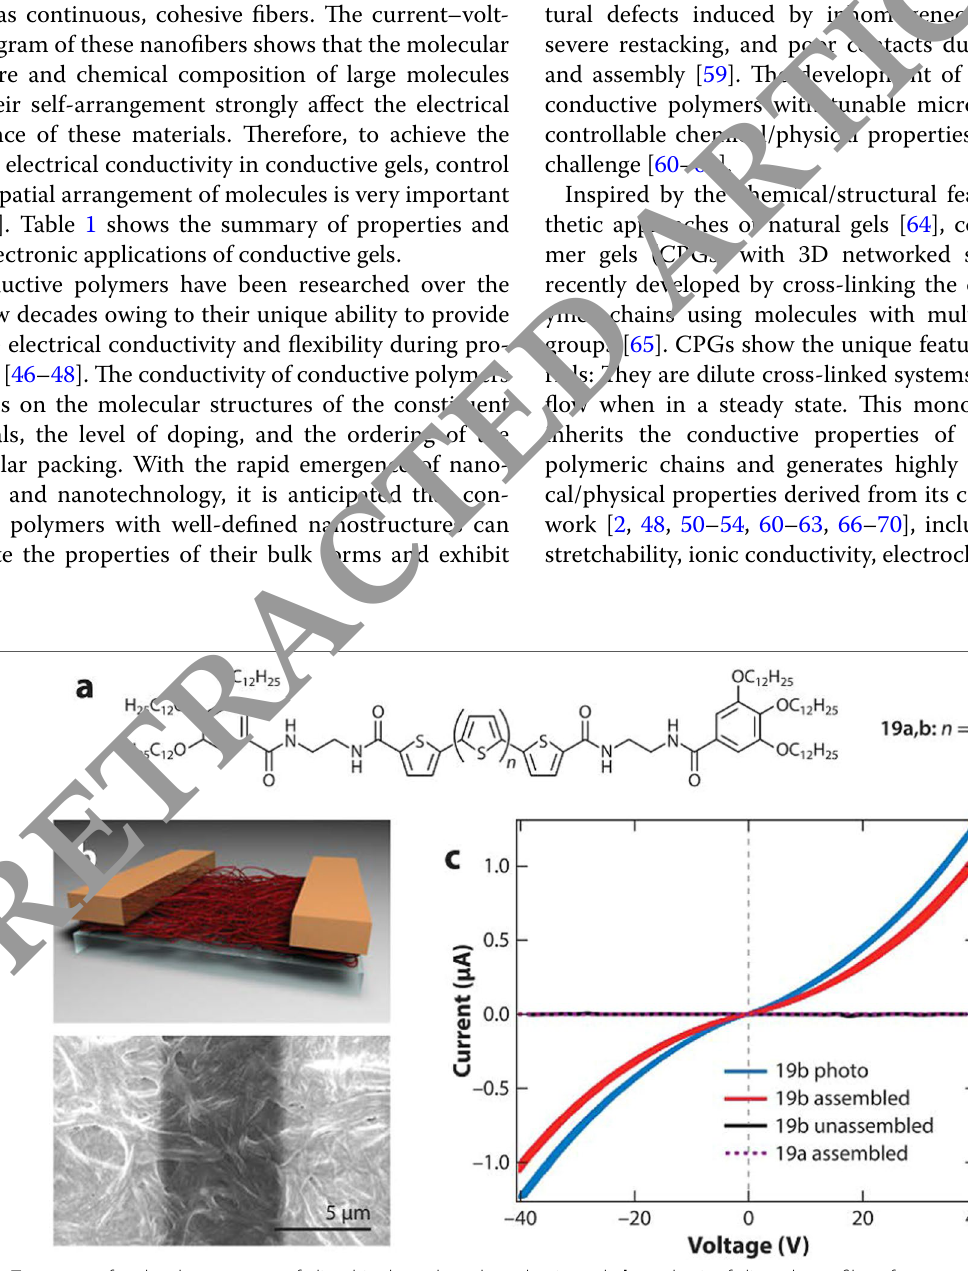
Fig. 2 a Two types of molecular structures of oligothiophene-based conductive gels; b synthesis of aligned nanofibers from conductive gels; c current–voltage diagrams of structures 19a and 19b in both self-arranged and non-self-arranged states [56]